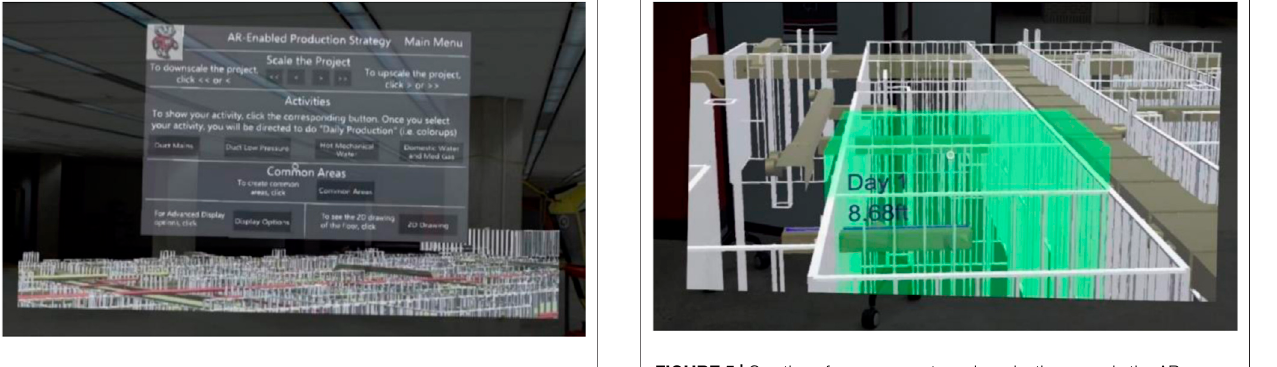
FIGURE 4 | User ’ s First View of the AR-Enabled PSP. Reprinted from Nassereddine (2019), fi g. 65, p. 213.